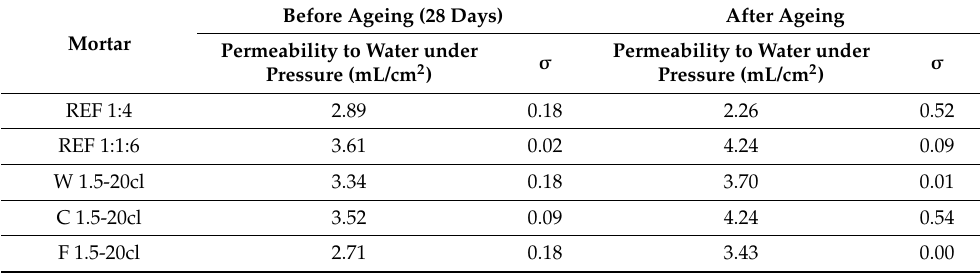
Table 3. Permeability to water under pressure